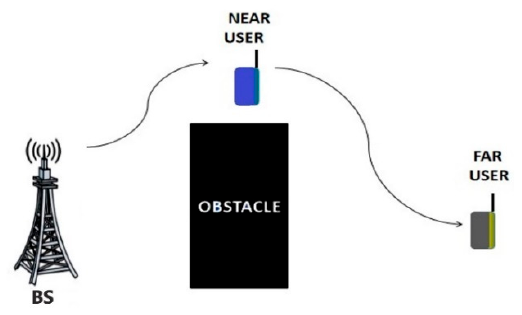
Figure 3. Model of cooperative SWIPT THz-NOMA.